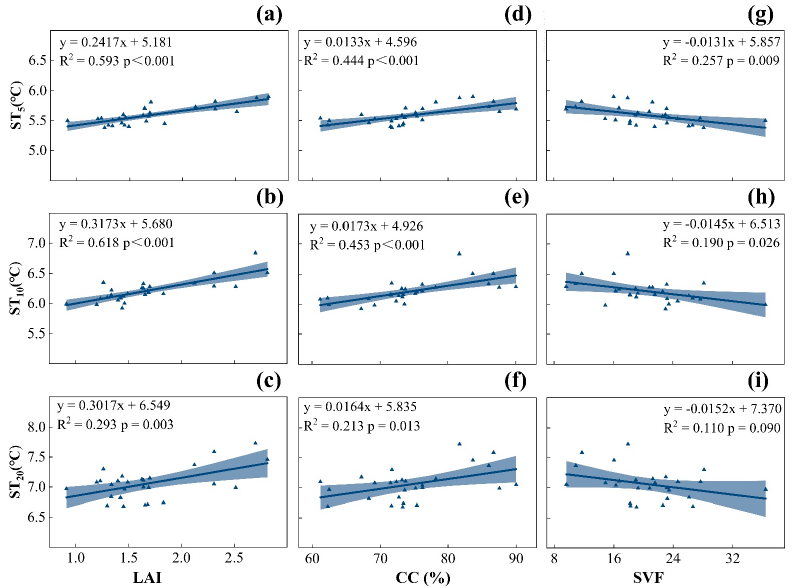
Figure 9. In winter, relationships between LAI in relation to different depths of ST at 5 cm ( a ), 10 cm ( b ), 20 cm ( c ); relationships between CC in relation to different depths of ST at 5 cm ( d ), 10 cm ( e ), 20 cm ( f ); relationships between SVF in relation to different depths of ST at 5 cm ( g ), 10 cm ( h ), 20 cm ( i ).